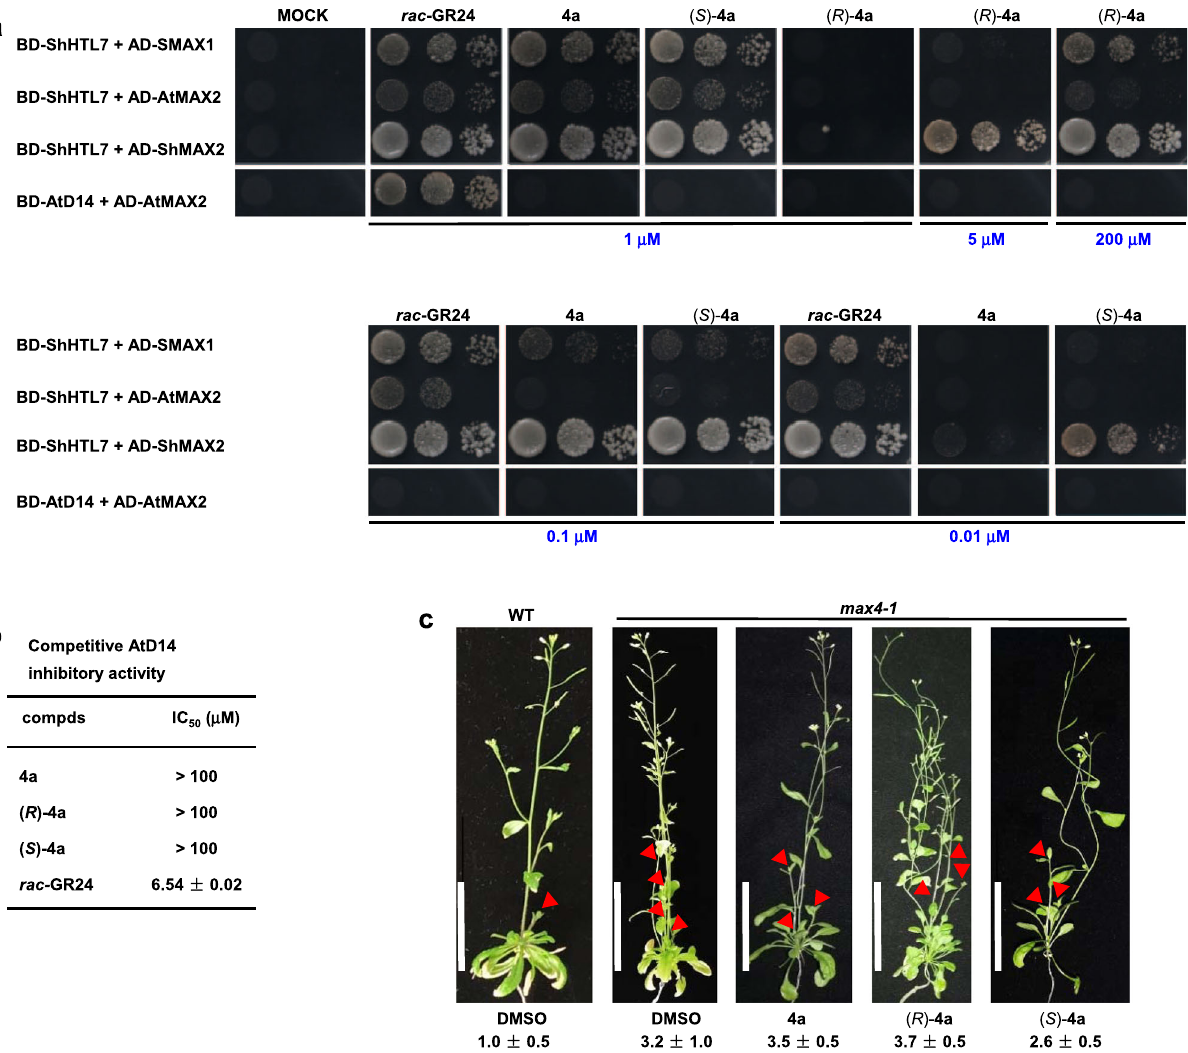
Fig. 4 Bioassays with compounds 4a, ( R )-4a, and ( S )-4a. a Yeast two-hybrid assays for ShHTL7 and AtD14 interactions with SMAX1, AtMAX2, ShMAX2, respectively. ShHTL7 and AtD14 were fused to GAL4-BD, SMAX1, AtMAX2, ShMAX2 were fused to GAL4-AD. Serial 10-fold dilutions of yeast cultures were spotted onto a selective growth medium that was supplemented with different concentrations of rac -GR24, 4a , ( R )- 4a , and ( S )- 4a , respectively. Images show growth after 3 days on SD/-Leu-Trp-His-Ade plates at 30 °C. b Competitive AtD14 inhibitory activity of 4a , ( R )- 4a , and ( S )- 4a using YLG as the substrate. Error bars mean SD ( n = 3 biologically independent experiments). c 4a , ( R )- 4a , and ( S )- 4a could not suppress the shoot branching phenotype of max4 - 1 , an SL biosynthetic mutant, at 1 μ M. The red arrowheads indicate axillary branches. No. of axillary shoots (over 0.5 cm) were shown as means ± SD ( n = 3 biologically independent experiments). Scale bar, 5